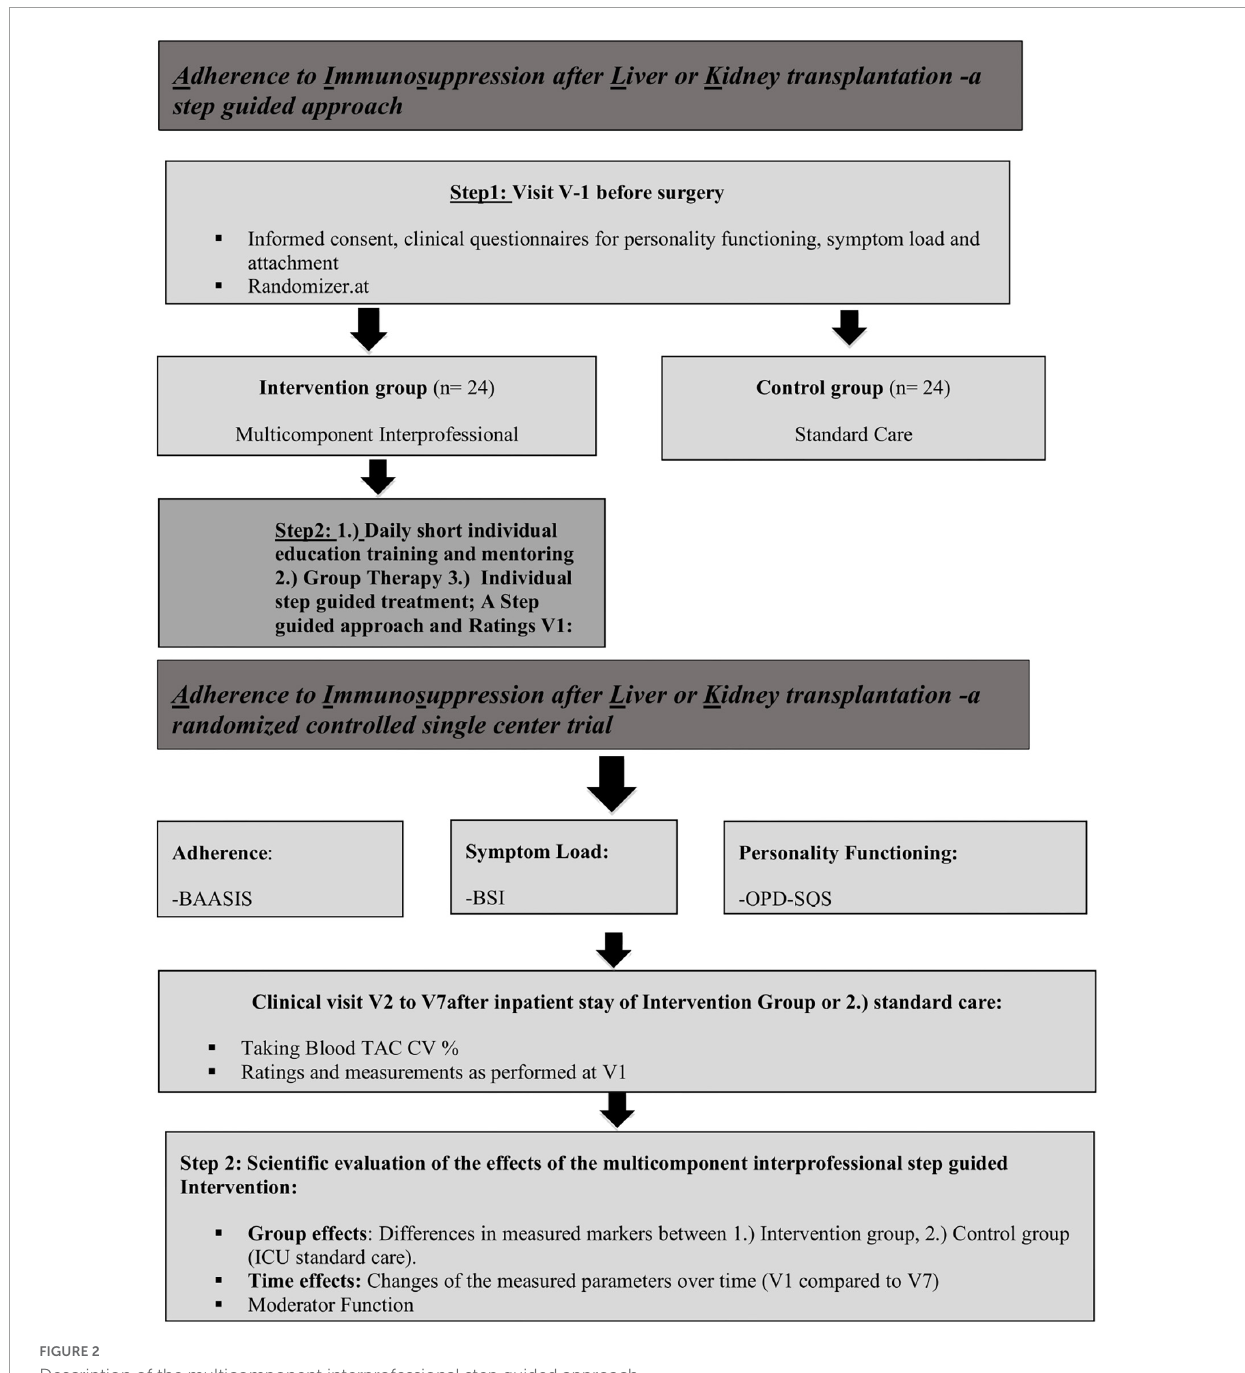
FIGURE2 Description of the multicomponent interprofessional step guided